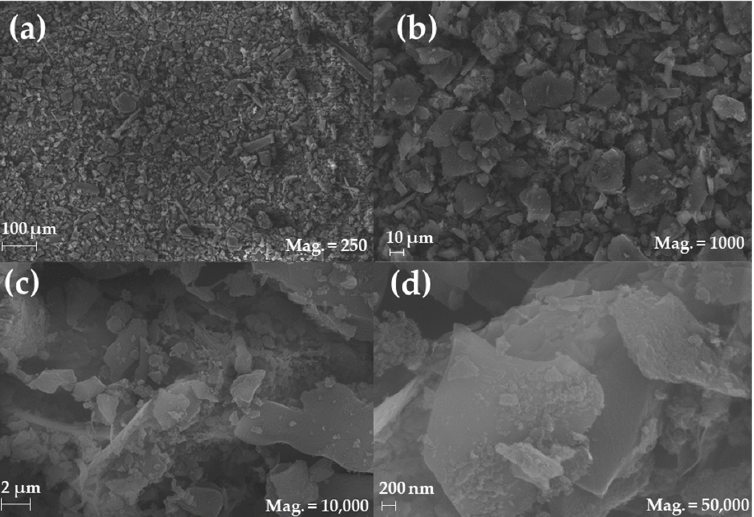
Figure 6. SEM images of the Cu/C catalyst, with magnifications from 250 to 50,000, ( a – d ). All images were taken with following parameters: EHT = 20.0 kV, WD = 8.5 mm, SingalA = InLens. Energy-dispersive X-ray (EDX) spectroscopy measurements were taken in order to establish an elemental analysis of the catalytic materials, the results of which are displayed in Table 2.